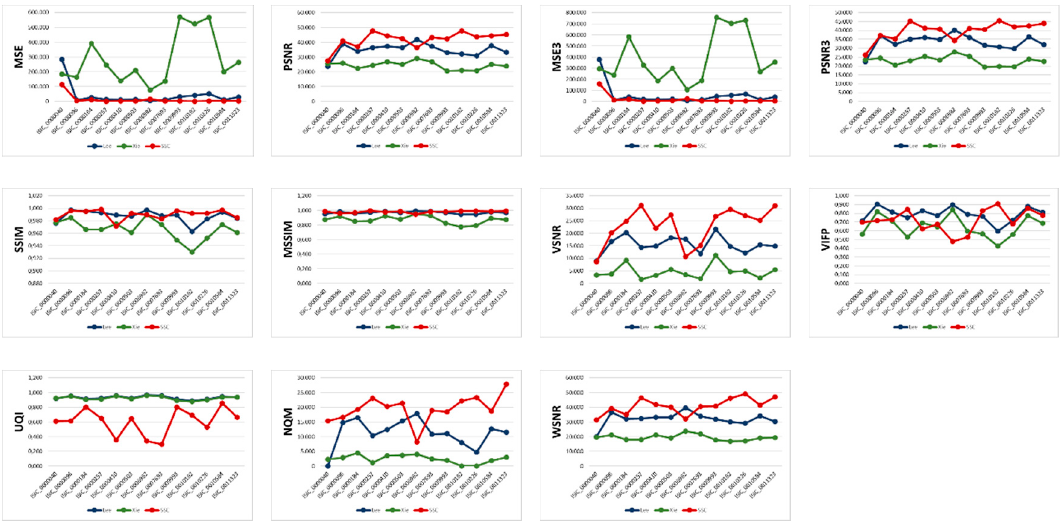
Figure 17. Trends of quality measures on sHSim-data for the methods Lee, Xie, and HR-SSC. To perform a quantitative evaluation based on area, we compare the area values obtained by the methods Lee, Xie, and HR-SSC on HSim-data , that is, the dataset in which hair is added in a controlled way. In detail, for each image I, we calculate the hair area introduced by the HairSim method, indicated as A I , and we compare this value with the area identified by each method, indicated as A L , A x , A R , respectively for Lee, Xie, and HR-SSC. For the sake of brevity, in Table 5, we show the resulting area values for sHSim-data . Moreover, we compare the average hair area <A I > introduced in HSim-data by the HairSim method with the average hair area detected by each method (Table 6). Table 5. Hair area on sHSim-data —best results are in bold.